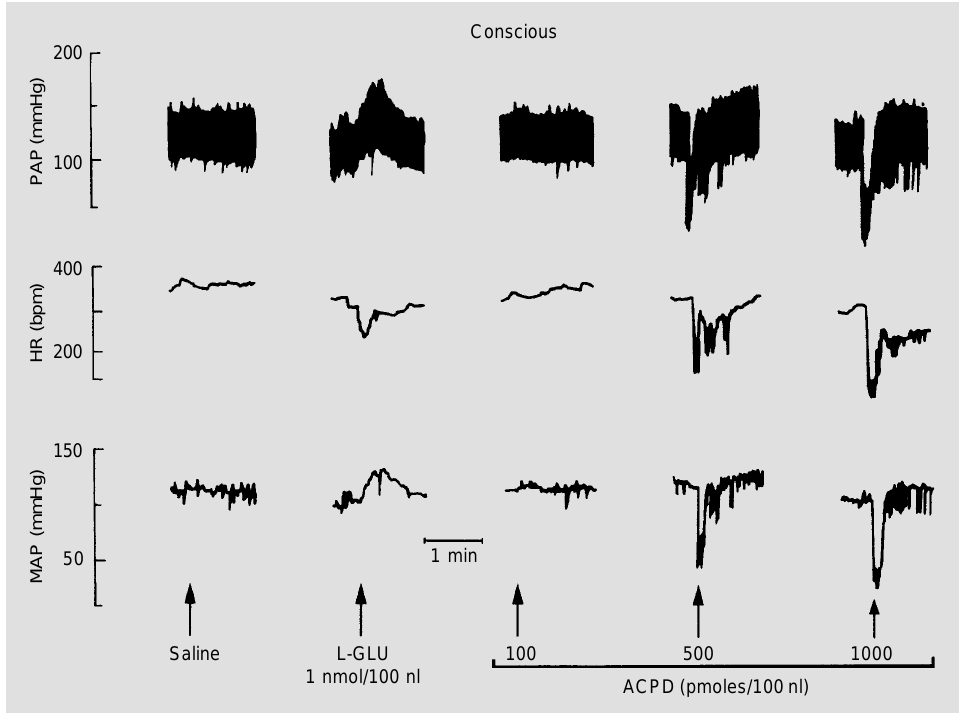
Figure 1 - Typical recordings of one rat representative of the group showing changes in pul- satile arterial pressure (PAP), heart rate (HR) and mean arteri- al pressure (MAP) in response to microinjections of saline (100 nl), L-glutamate (L-GLU; 1 nmol/ 100 nl) and increasing doses of trans-(±)-1-amino-1,3-cyclopen- tanedicarboxylic acid (ACPD) into the NTS under conscious conditions. Arrows indicate mi- croinjections into the NTS. Time interval between microinjec- tions was 10